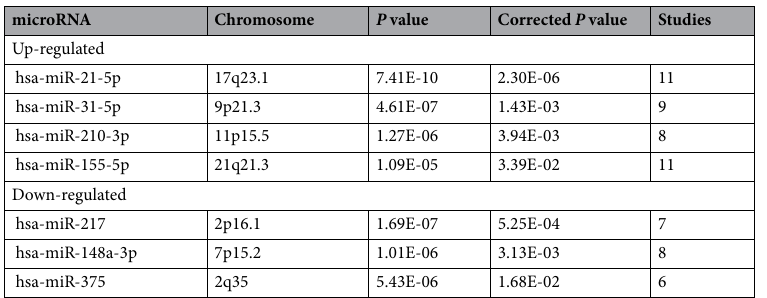
Table 1. Meta-signature miRNAs in PC